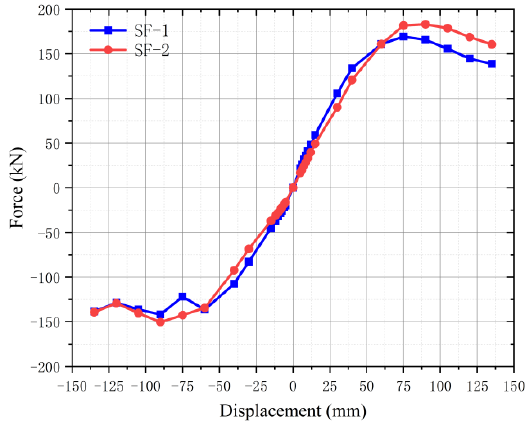
Figure 16. Skeleton curves of SF-1 and SF-2.